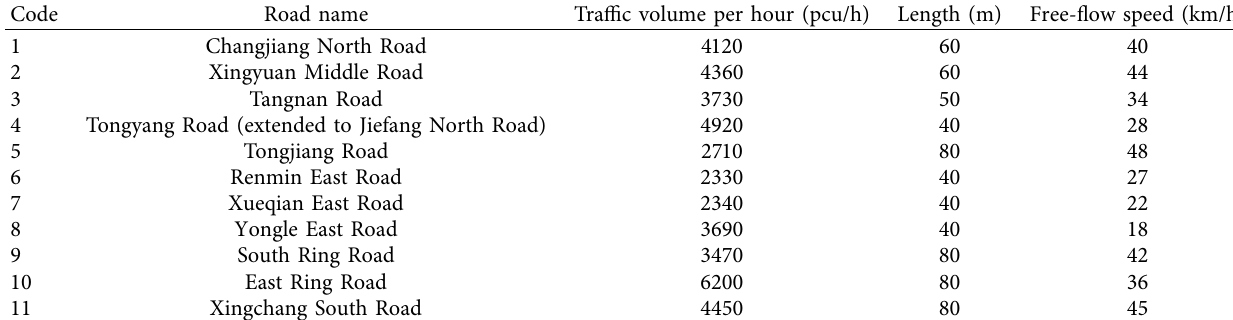
Table 11: The traffic speed of private cars on ordinary lanes.